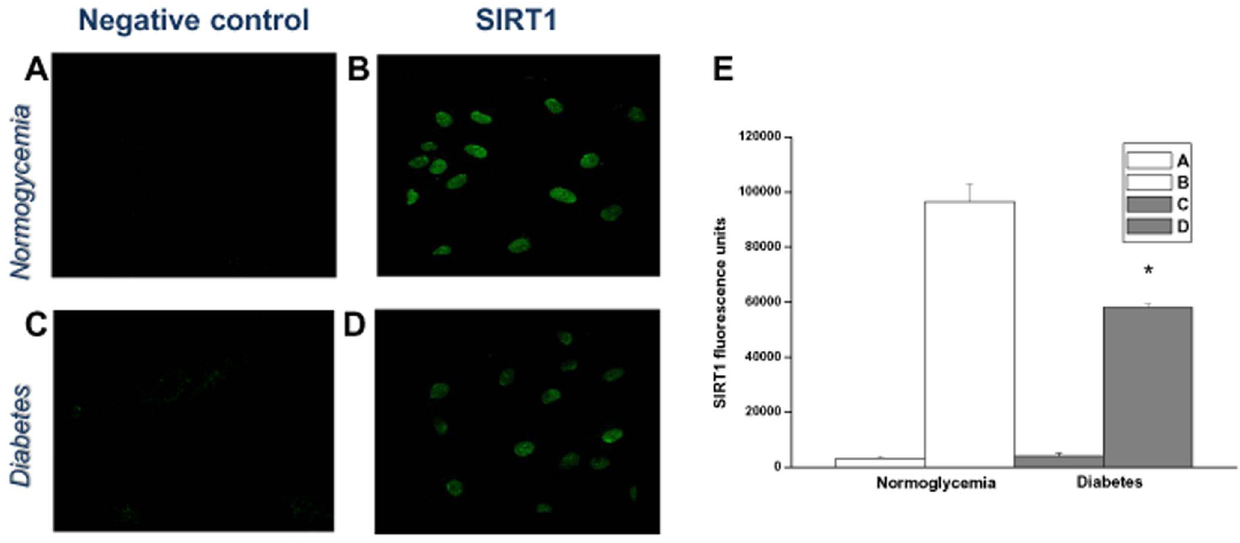
Figure 2. SIRT1 immuncytochemical detection in VSMCs from normoglycemic (A, B) and diabetic (C, D) rats. VSMCs were seeded (30,000/well) at passage 6 in 24-well plates. Two days after plating cells were probed with rabbit antibody to SIRT1 (1:200) and then incubated with a secondary phycoerythrin-conjugated anti-rabbit antibody (1:500) for 30 min at room temperature. VSMCs that received secondary antibody but no SIRT1 primary antibody were used as a negative control. 60 6 magnification. ( E ) Densitometric analyses of 3 separate experiments using ImageJ. * p , 0.05 vs normoglycemia.